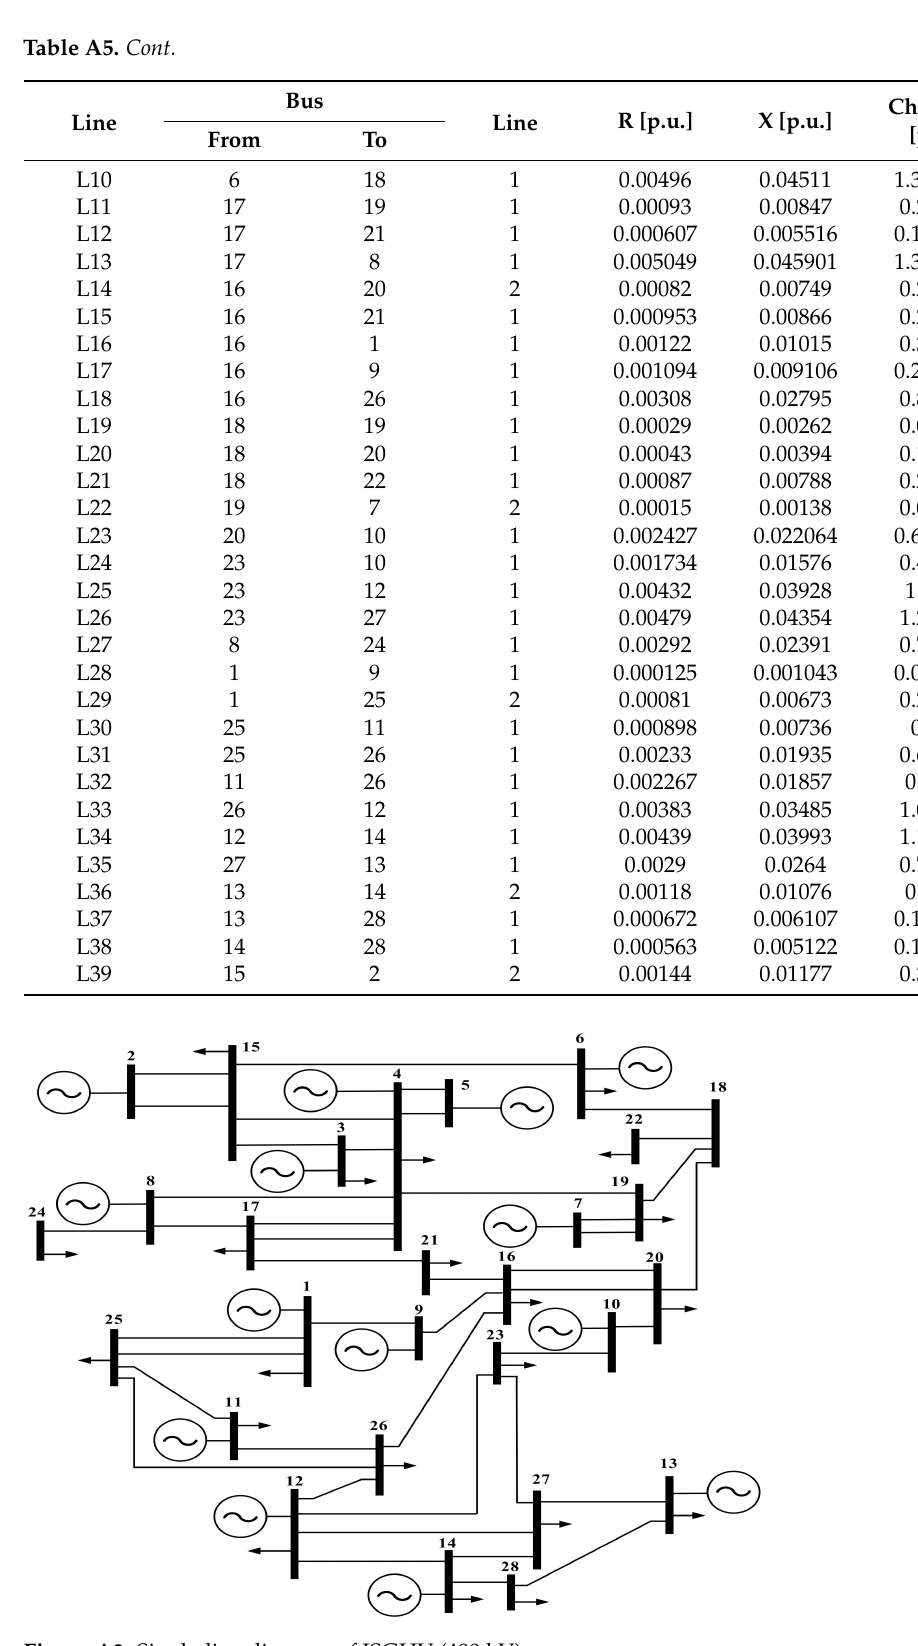
Figure A3. Single-line diagram of ISGHV (400